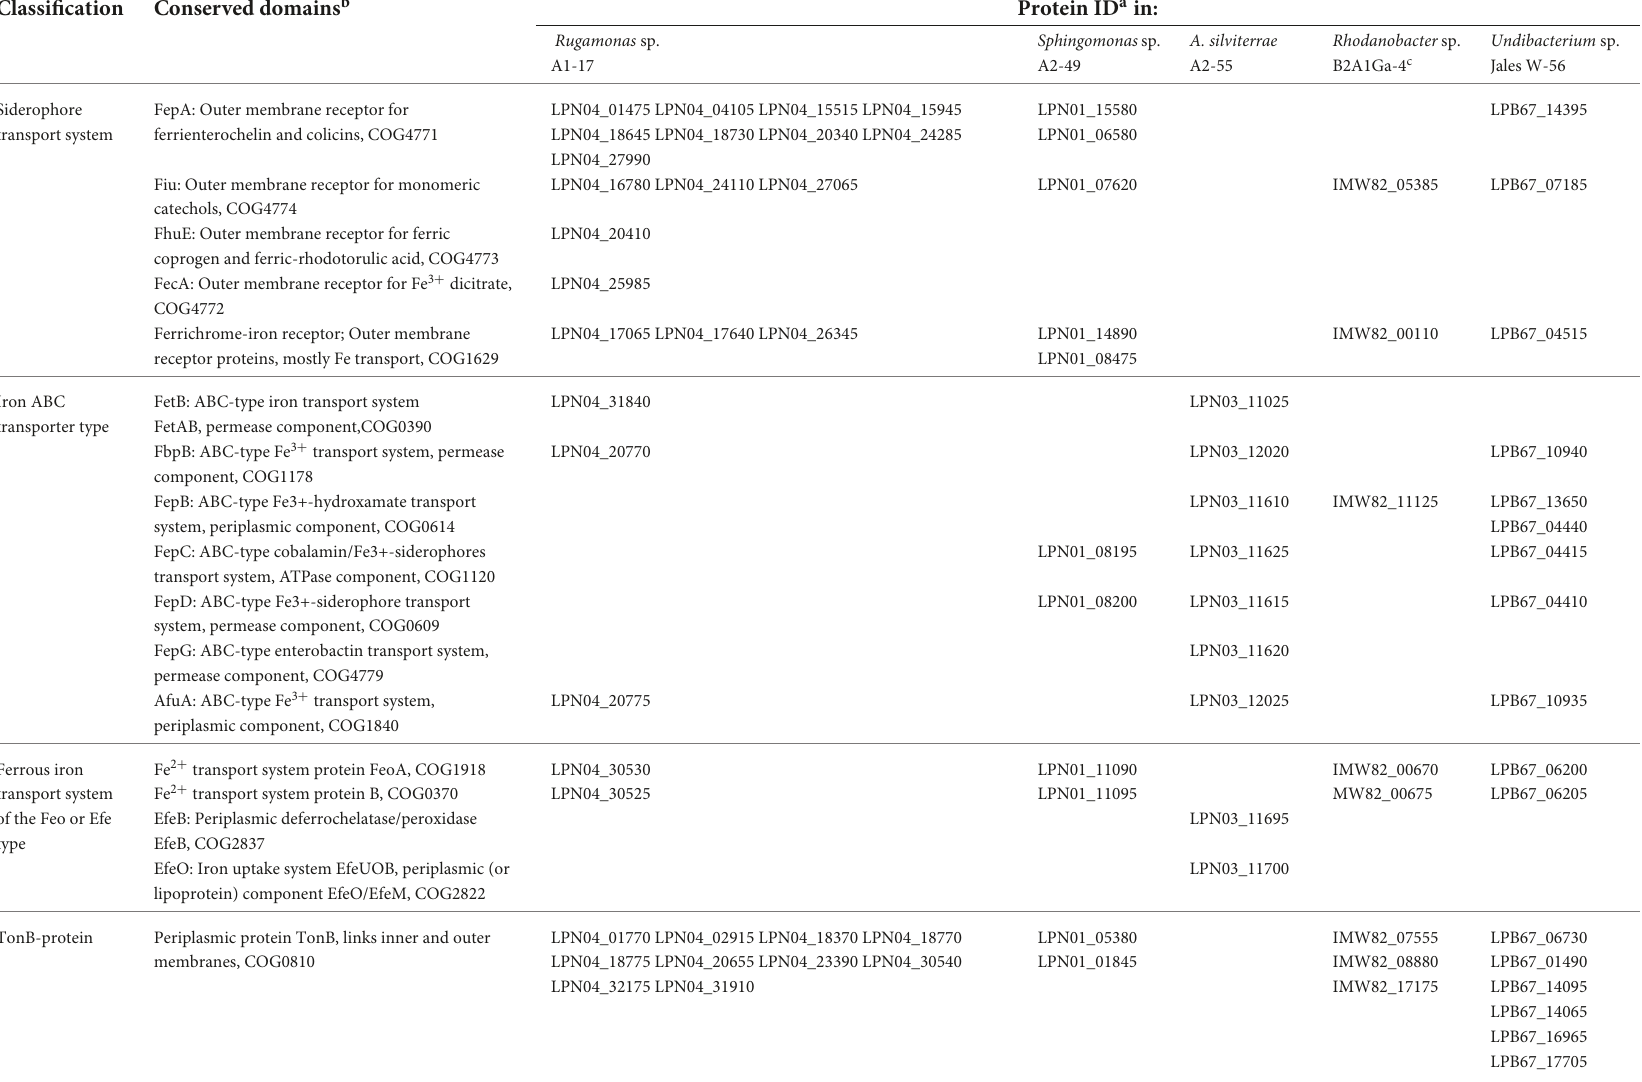
a ProteinIDinNCBIProkaryoticGenomeAnnotationPipeline. b ConserveddomainsobtainedinNCBIdatabase,COG(ClustersofOrthologousGroups)ofproteins. c